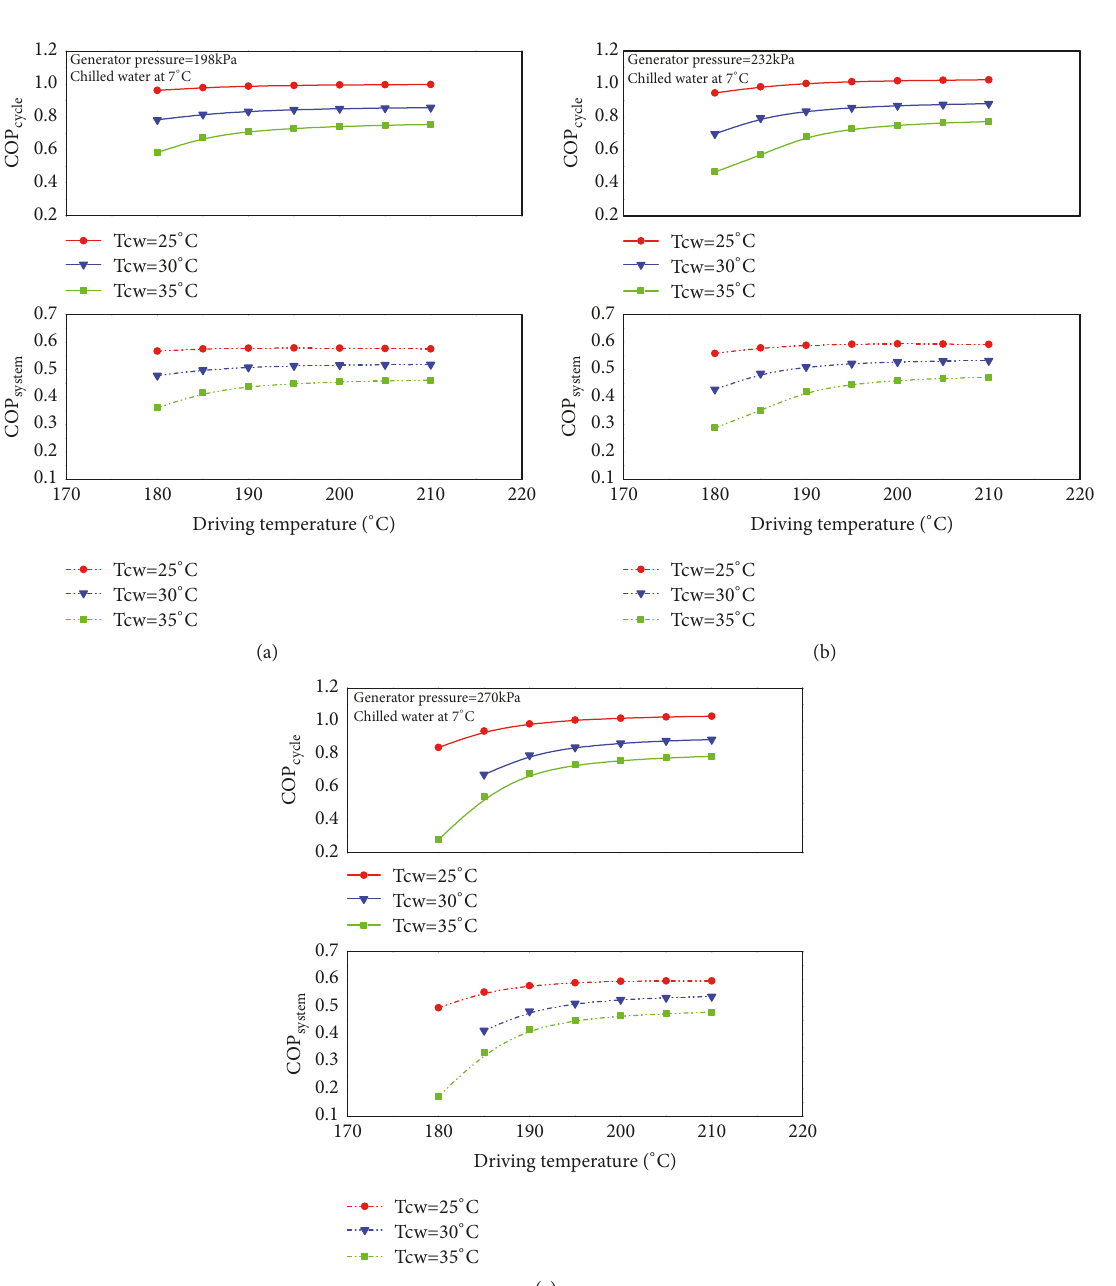
and the 𝐶𝑂𝑃 𝑠𝑦𝑠𝑡𝑒𝑚 = 0.57, 0.59, 0.6 for generator pressures at 198 kPa, 232 kPa, 272 kPa,